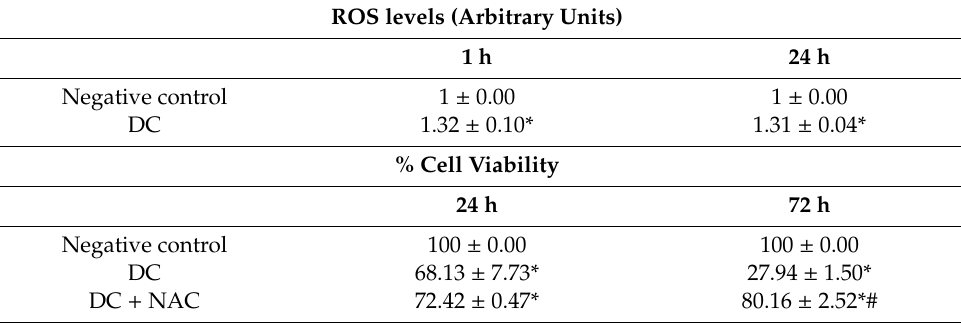
Table 3. Role of reactive oxygen species (ROS) levels on cell death triggered by DC. Above: measurement of ROS levels expressed as arbitrary units of fluorescence in Caco-2 cells incubated for 1 h and 24 h with the drug combination (DC). Fluorescence data were normalized with cell viability. Below: analysis of Caco-2 cell viability pre-incubated with NAC and then treated 24 h and 72 h with DC. ROS levels (Arbitrary Units)